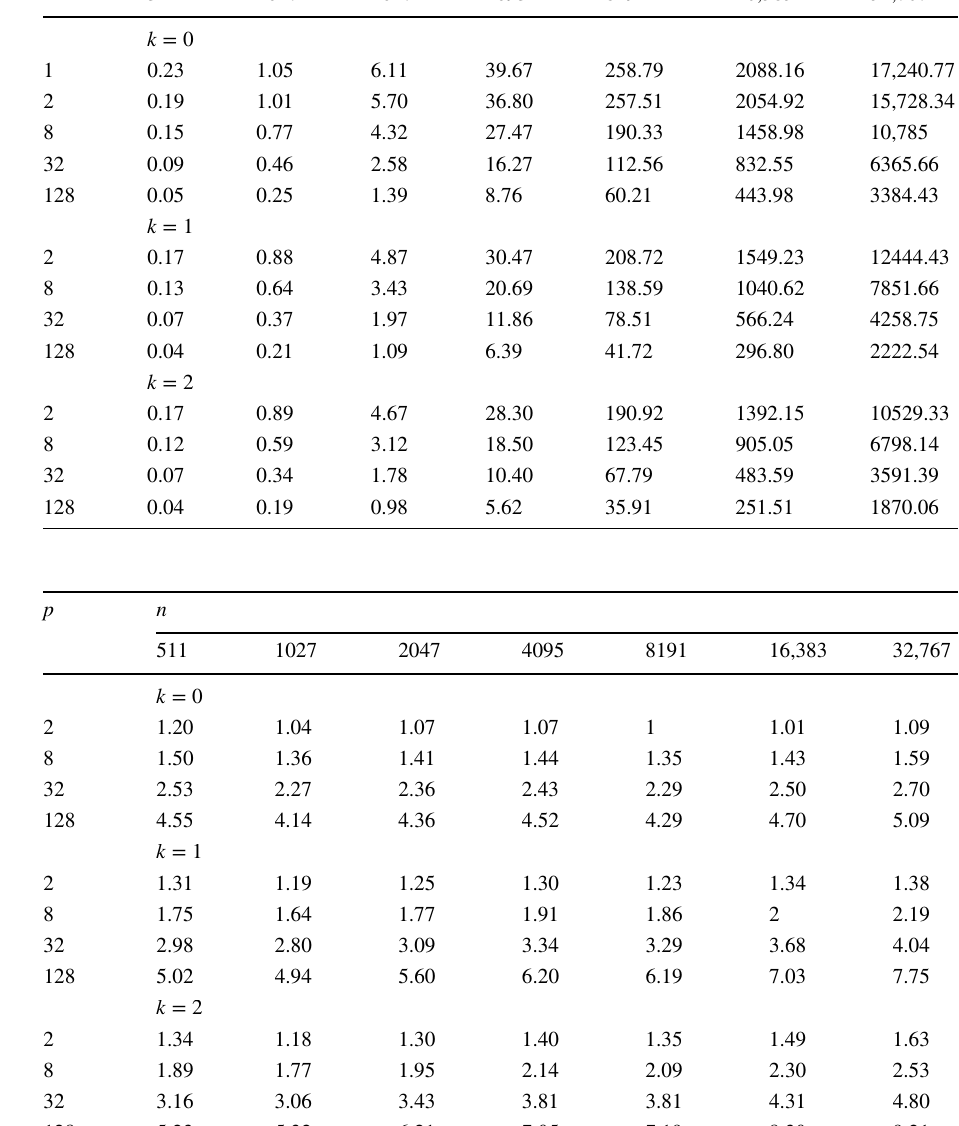
1,2,8,32,128 } for p ∈ { n ∈ { 511,1023, … ,16,383,32,767 } 0,1,2 } and k ∈ {